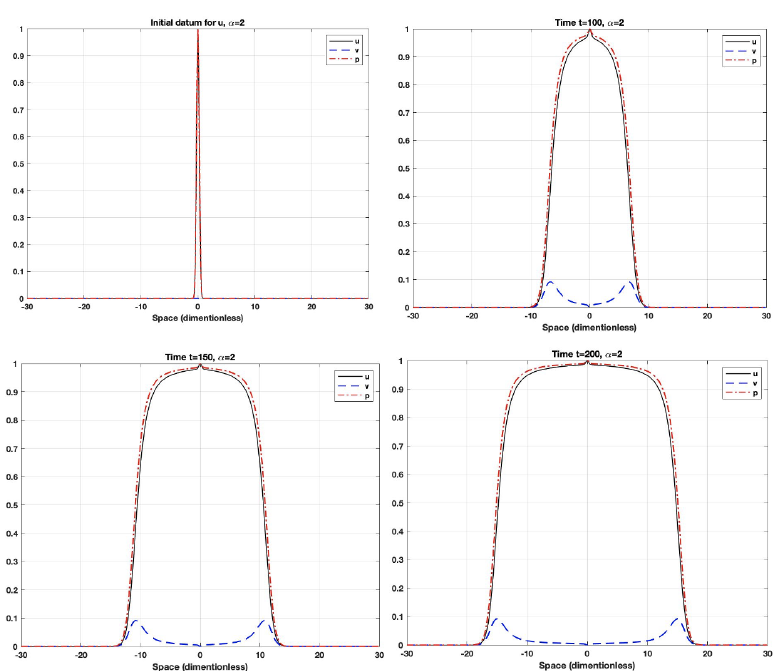
Figure 4. Distribution of CSCs (black), NSCCs (blue) and total tumour density (red). For high mortality rate of NSCCs ( α = 2 ) at various total times T ∈ { 0,100,150,200 } and fractional order of time derivative β = 0.85.